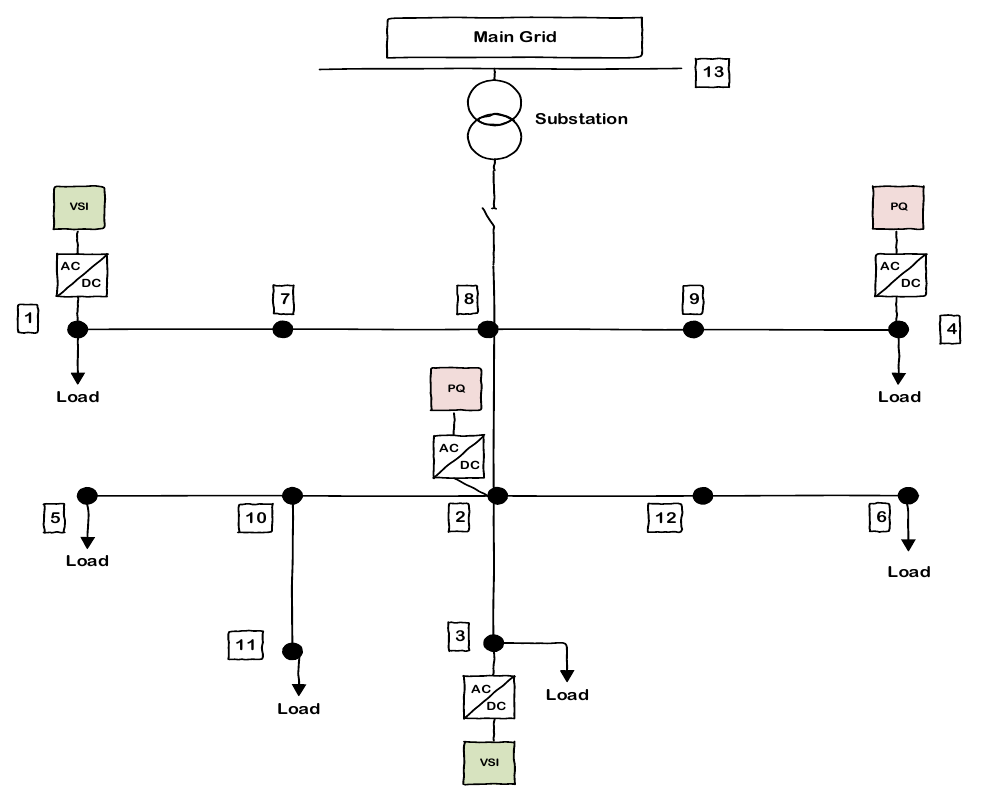
Figure 15. Test System with 12 buses and 4 inverters.